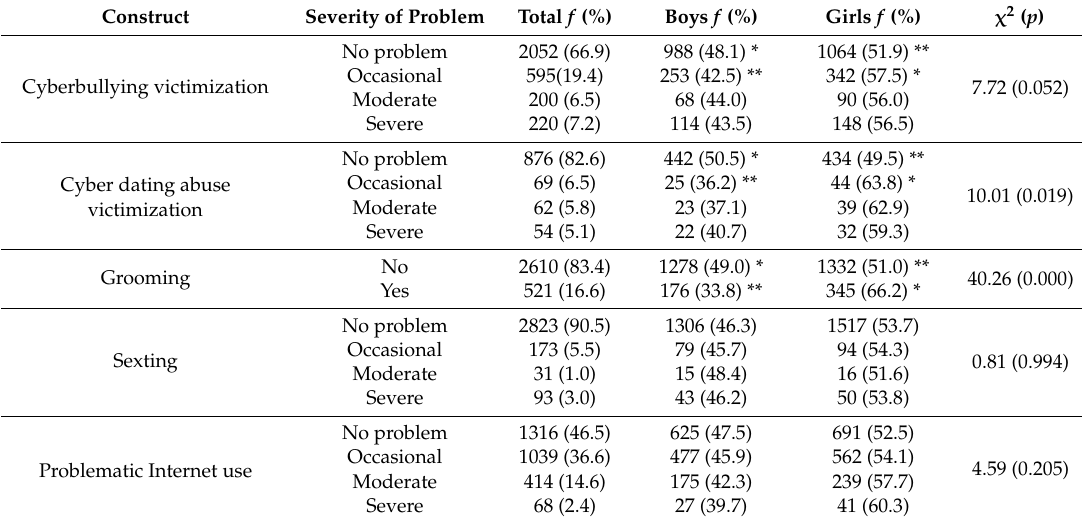
Table 1. Prevalence of each of the risks as a function of the severity of the problem for the total sample and of